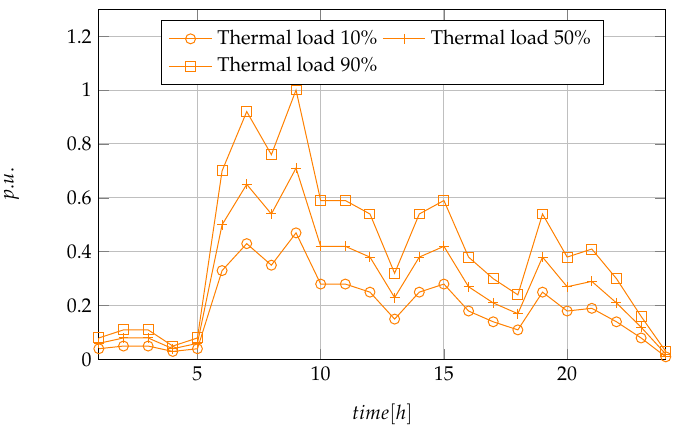
Figure 6. Example of normalized thermal load probabilistic